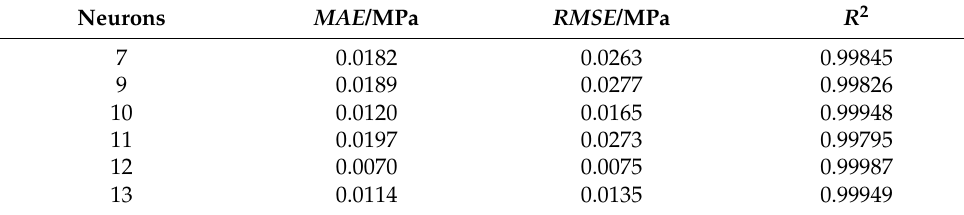
Table 6. Performance statistics of different number of neurons.